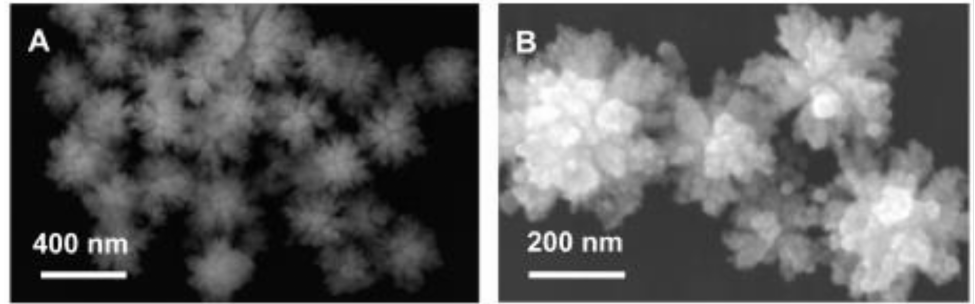
Figure 7. Low- ( A ) and high-magnification ( B ) SEM images of dendrite-like PtAg nanocrystals, reprinted with permission of Elsevier